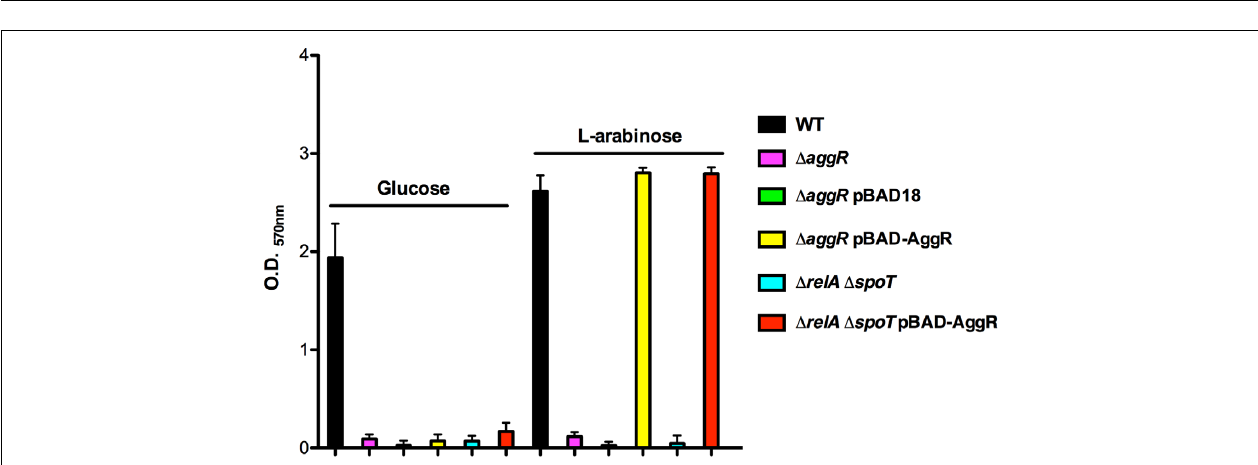
FIGURE 5 | Biofilm formation in the 042 strain is directly dependent on (p)ppGpp. (A) Crystal violet stain of biofilms formed by strains 042, 042 pAA - , 042 (cid:49) relA , and 042 (cid:49) relA (cid:49) spoT. (B) Biofilm quantification (OD 570 nm ). The data shown are the means and standard deviations of three independent experiments. Statistical analysis showed significant differences compared to the control ( ∗ P -value < 0.0001).